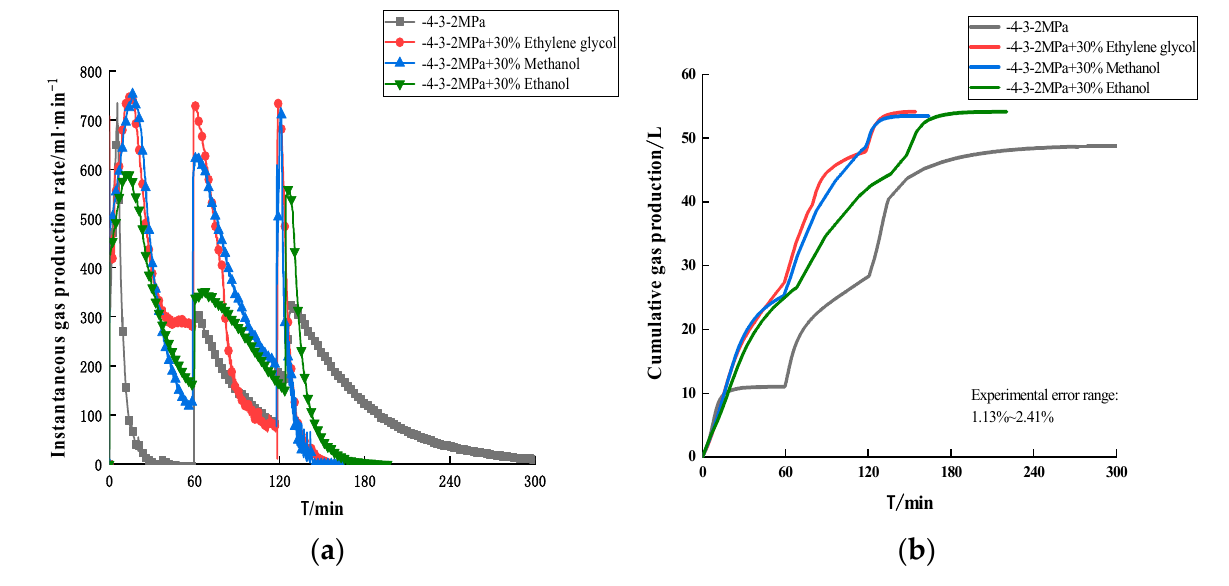
Figure 3. Decomposition curve of multi-stage depressurization and injection of 30% alcohol hydrate: ( a ) Instantaneous gas production rate; ( b ) Cumulative gas production. Table 1. Relevant experimental parameters of gas hydrate depressurization and alcohol injection production.